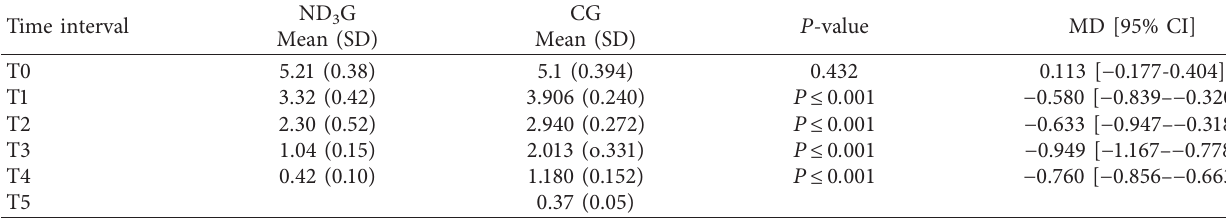
Table 3: Amount of crowding at various time intervals between groups.